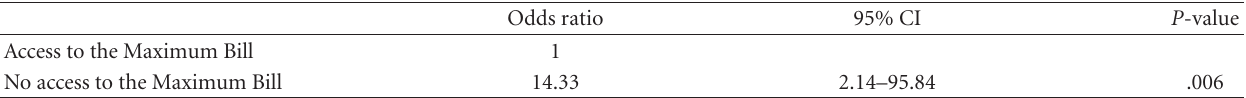
Table 3: Odds ratio for the chance of being in the low caries risk group (adjusted for age, gender, and occupational